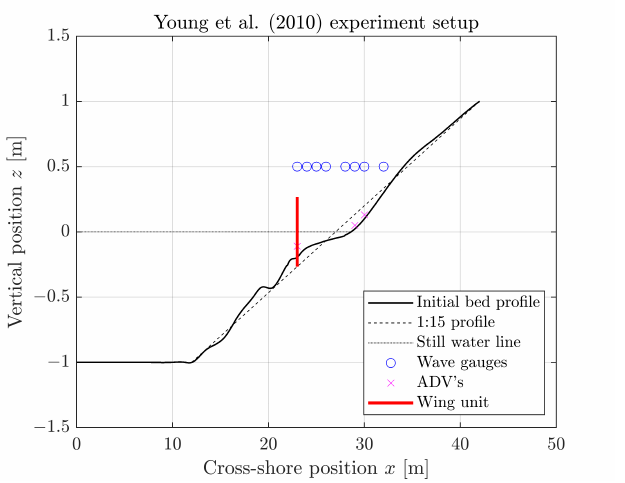
Figure 1. Schematic overview of the experiment setup of Young et al. [33], showing only the instru- ments used in this